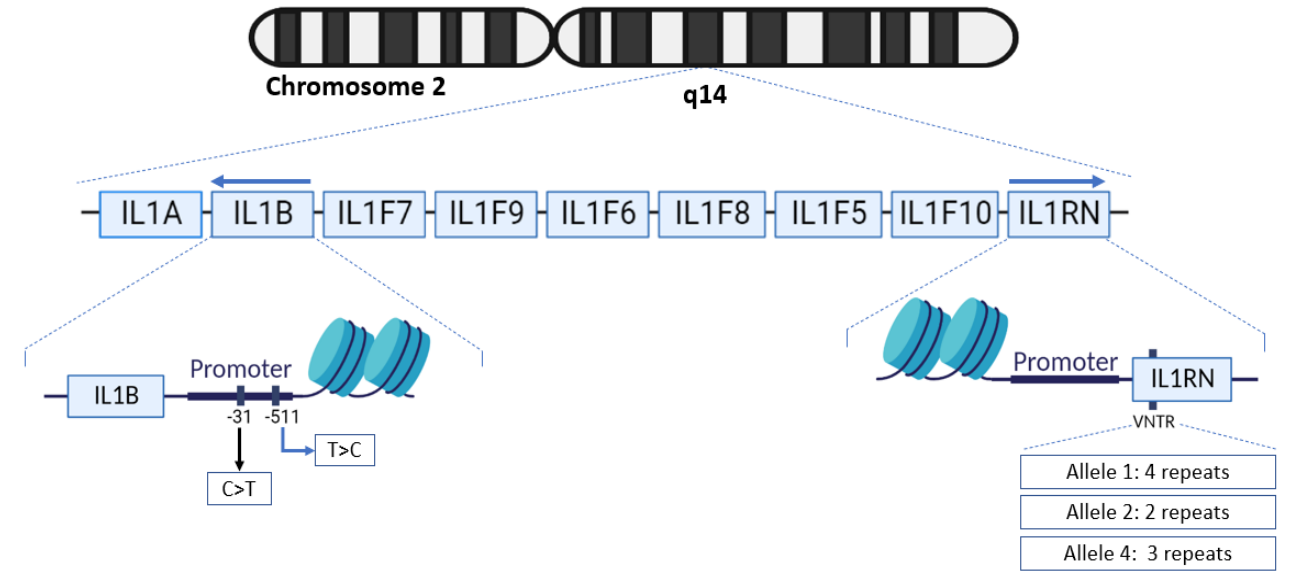
Figure 1. Representation of the IL1 genes cluster, where genes are represented by the boxes and placements of polymorphisms of interest are visualized. In the figure, distances of each gene are not representative of their actual length.